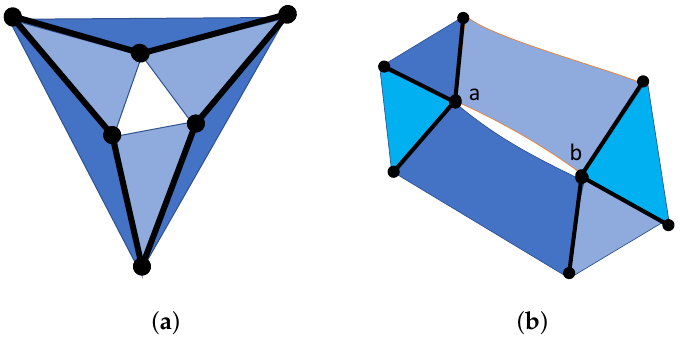
Figure 58. Two body–hinge cycles of length 6 in 3-space, one isostatic ( a ) forming an octahedron, and one geometrically singular ( b ) with all hinges meeting a single line through two